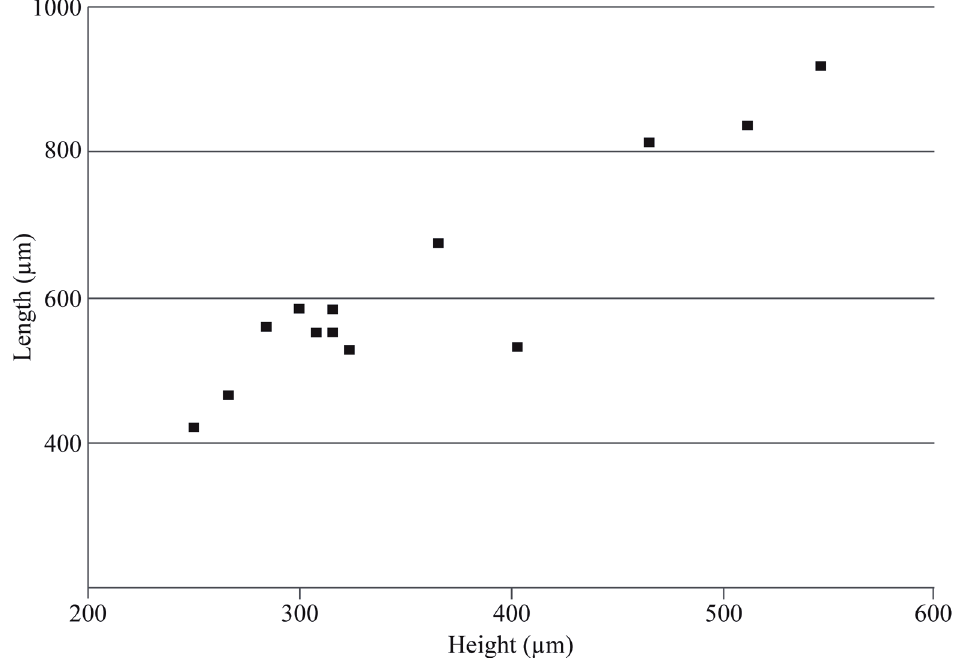
Fig. 12. Height/length diagram of Orthobairdia jeanlouisi sp.